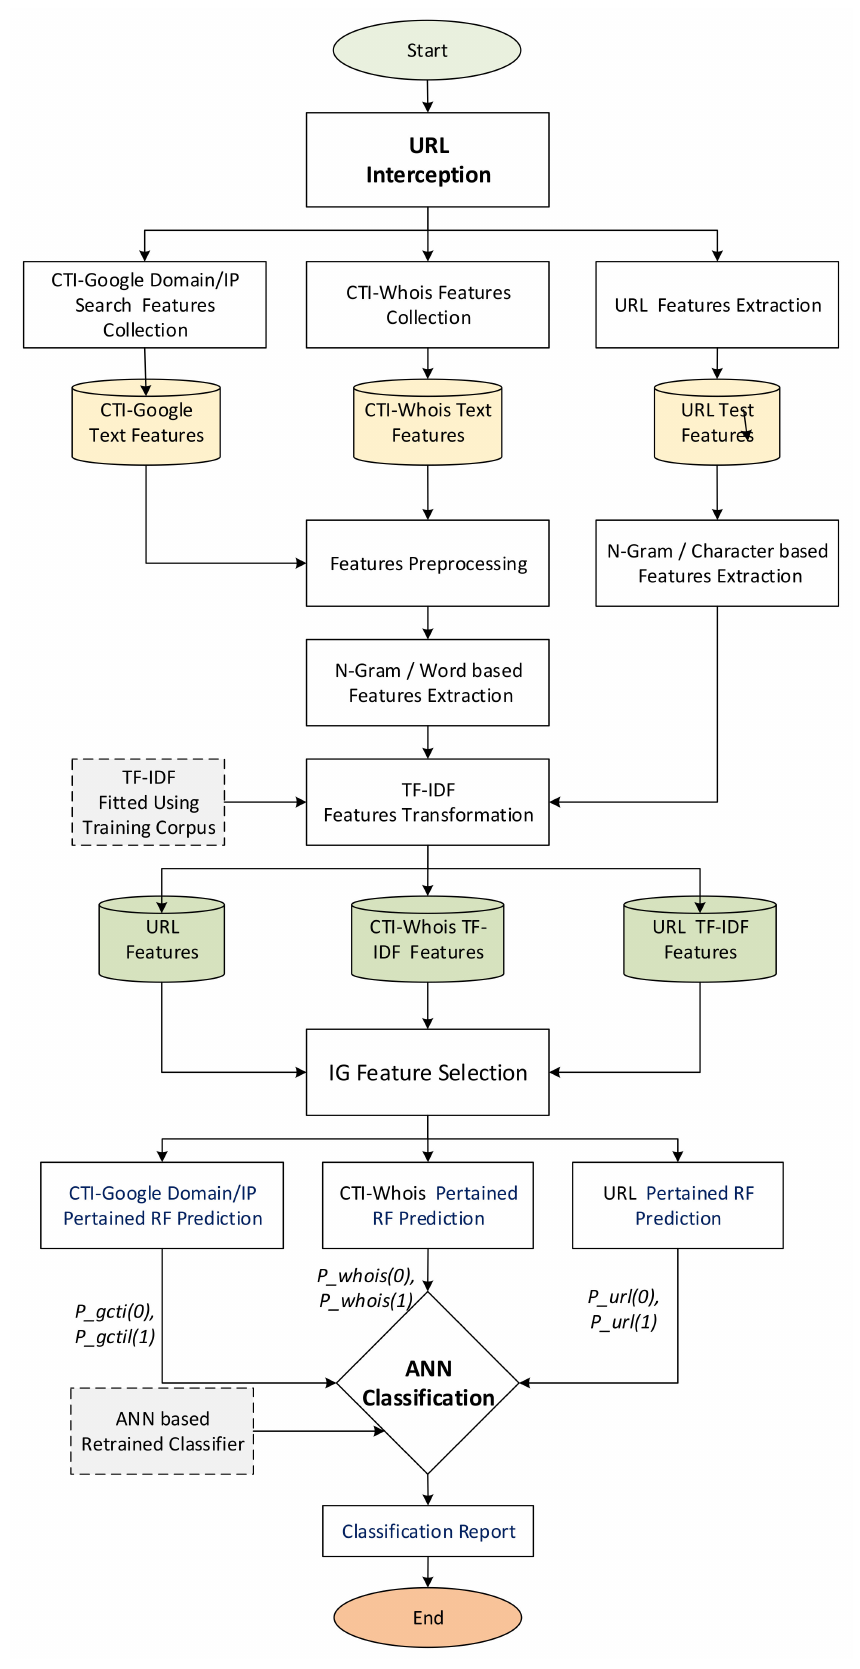
Figure 3. Flowchart of the CTI-MURLD model